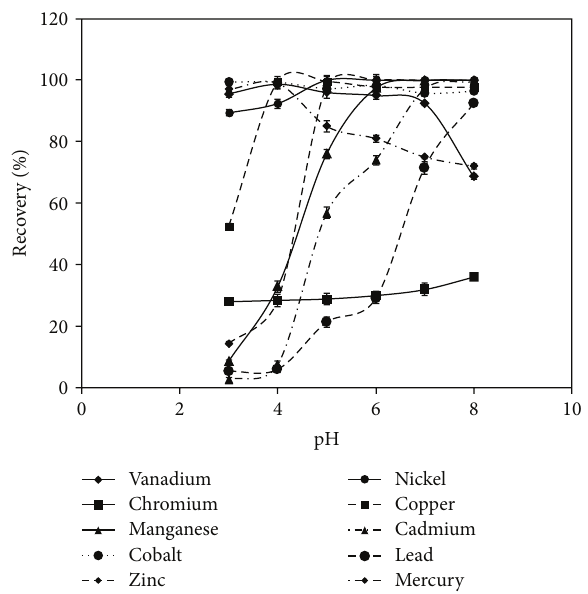
Figure 1: Effect of pH variation on the adsorption of metals. Conditions: volume: 200 mL, m(5Ph8HQ): 1g, and [M + ]: 1 𝜇 gmL −1 in single-metal solution. Bars represent standard deviation for two